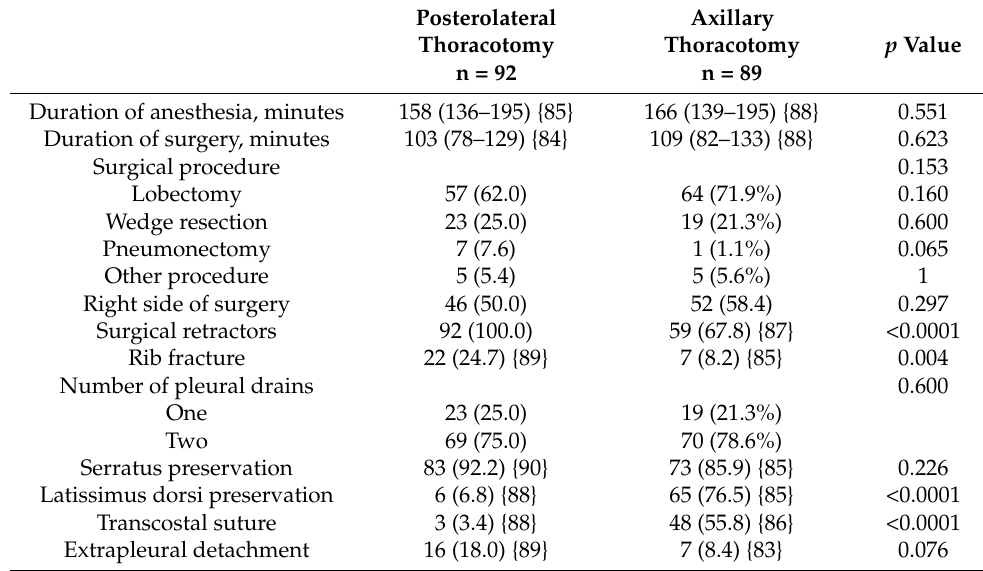
Table 2. Intraoperative variables in posterolateral and axillary